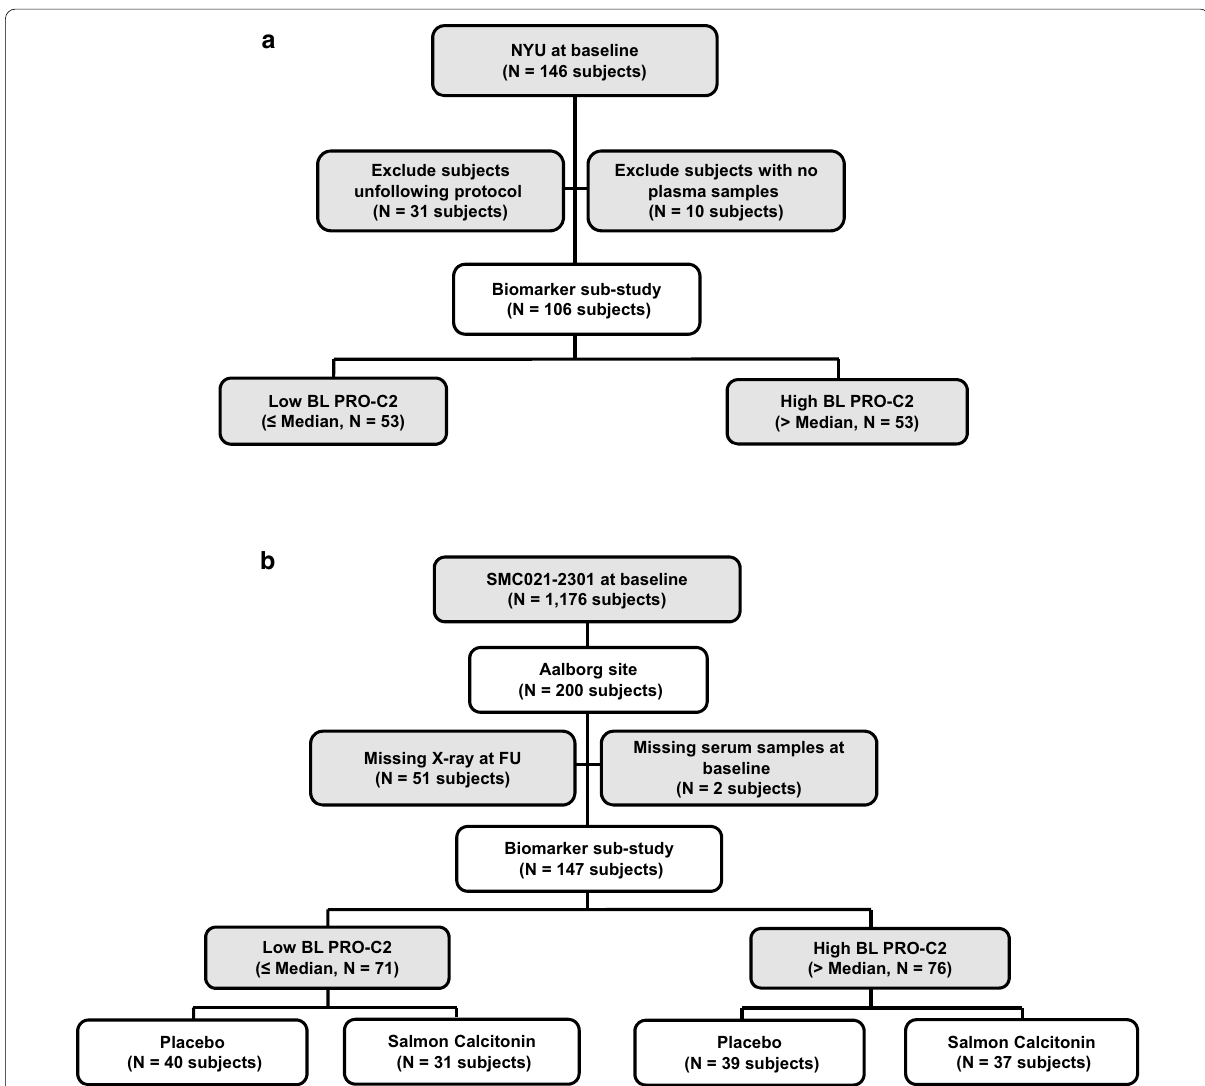
Fig. 1 Flow diagrams for subjects included in the PRO‑C2 post hoc analyses. a The NYU cohort. b The SMC